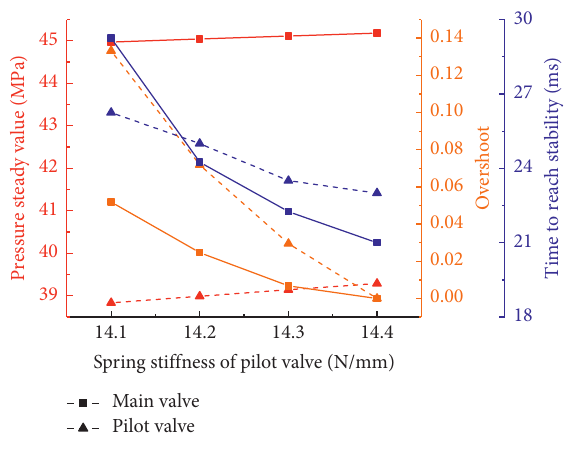
Figure 9: Dynamic response